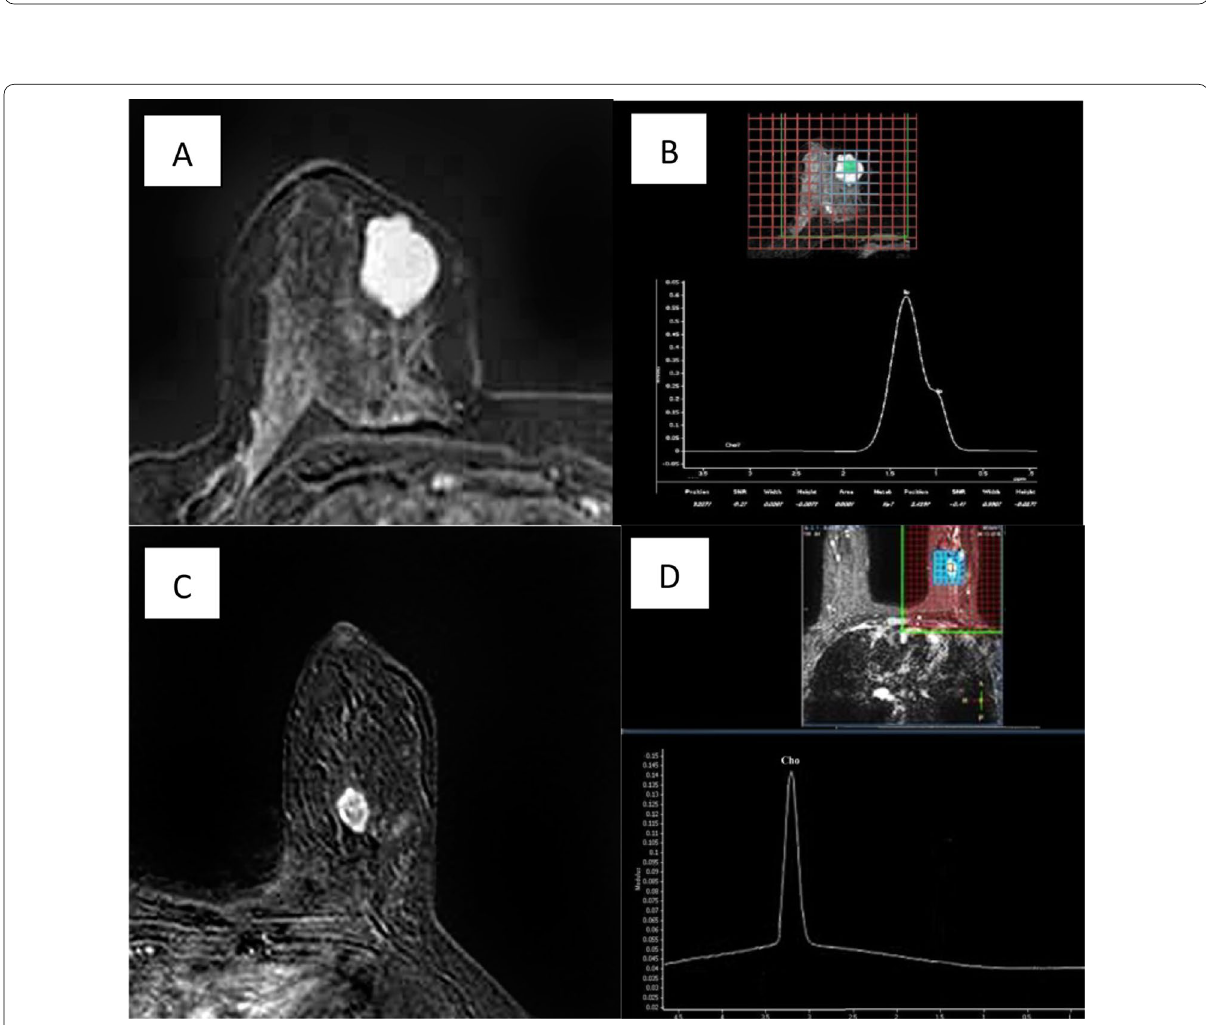
Fig. 6 Two different female patients: the first patient aged 36 years old and had right breast fibroadenoma. A Axial postcontrast T1-WI with subtraction, showing a well-circumscribed lobulated homogenously enhancing right breast mass. B MRS study showing absent choline peak. The second patient aged 42 years and had left breast mucinous carcinoma. C Axial postcontrast T1-WI with subtraction, showing a partially circumscribed heterogeneously enhancing left breast mass. D MRS study showing positive choline